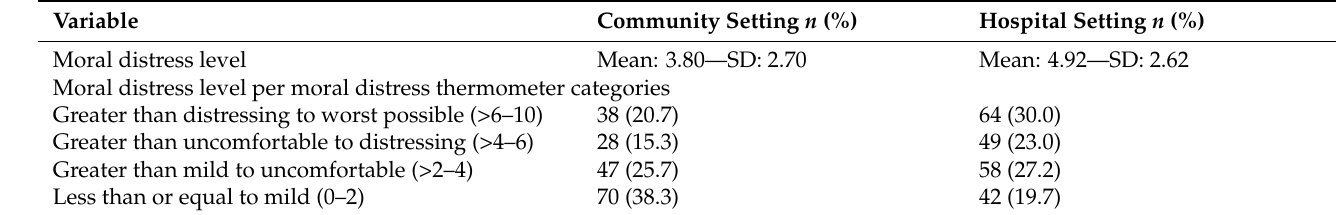
Table 4. Level of moral distress among healthcare